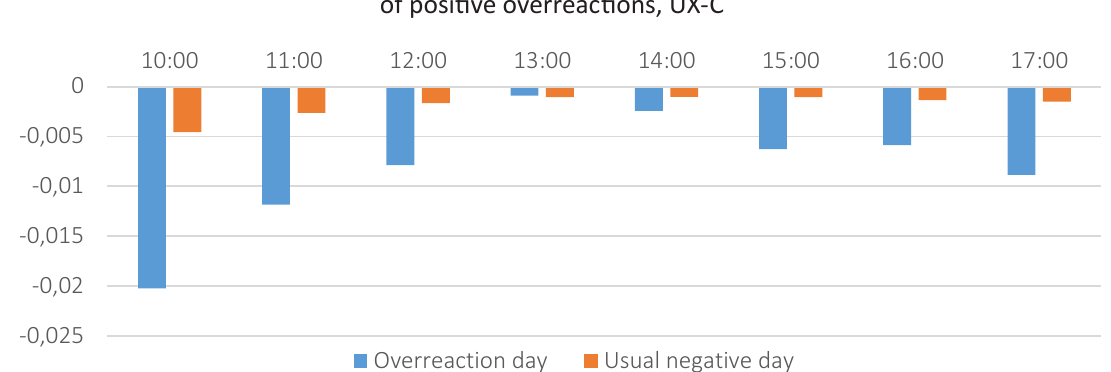
Figure 2. Average hourly returns on overreaction and normal days: the case of negative overreactions,